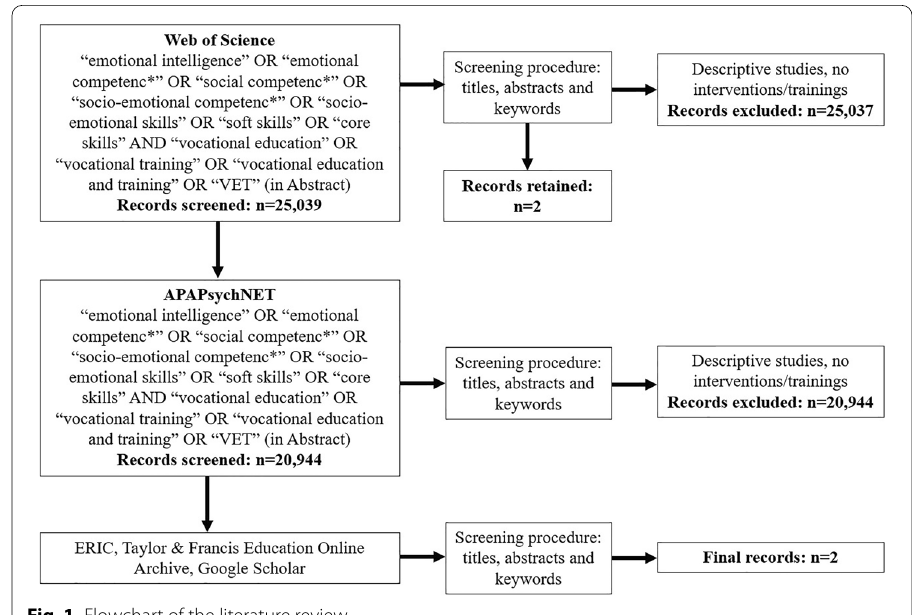
Fig. 1 Flowchart of the literature